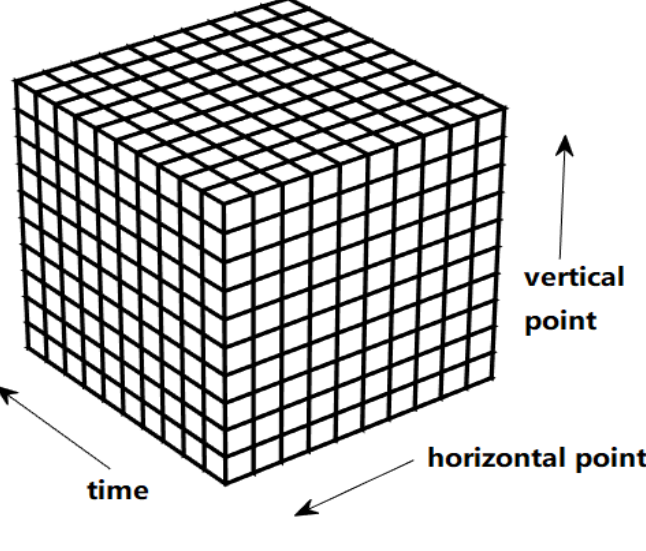
Figure 3. Radar Cube Data.